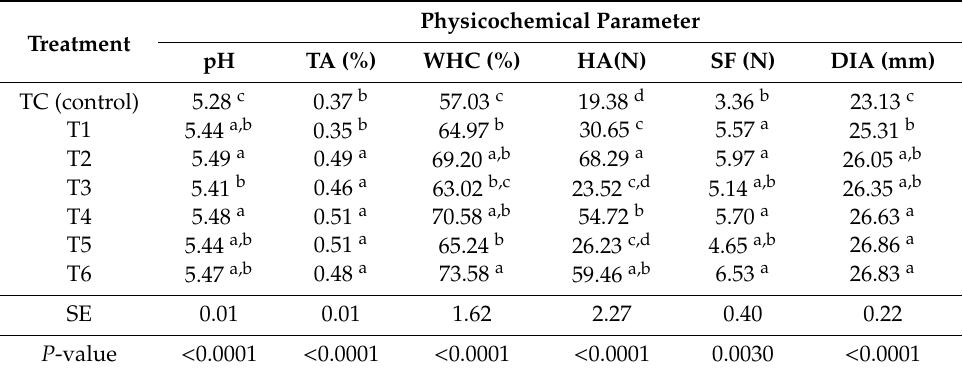
Table 1. Physicochemical parameters of frankfurter sausages